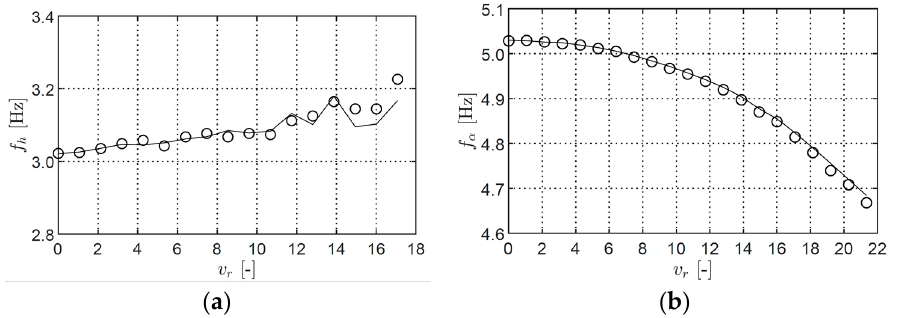
Figure 22. Frequency values: ( ― ) Hilbert transform method, (O) frequency obtained through FFT of filtered acceleration response. ( a ) Heave response; ( b ) pitch response.